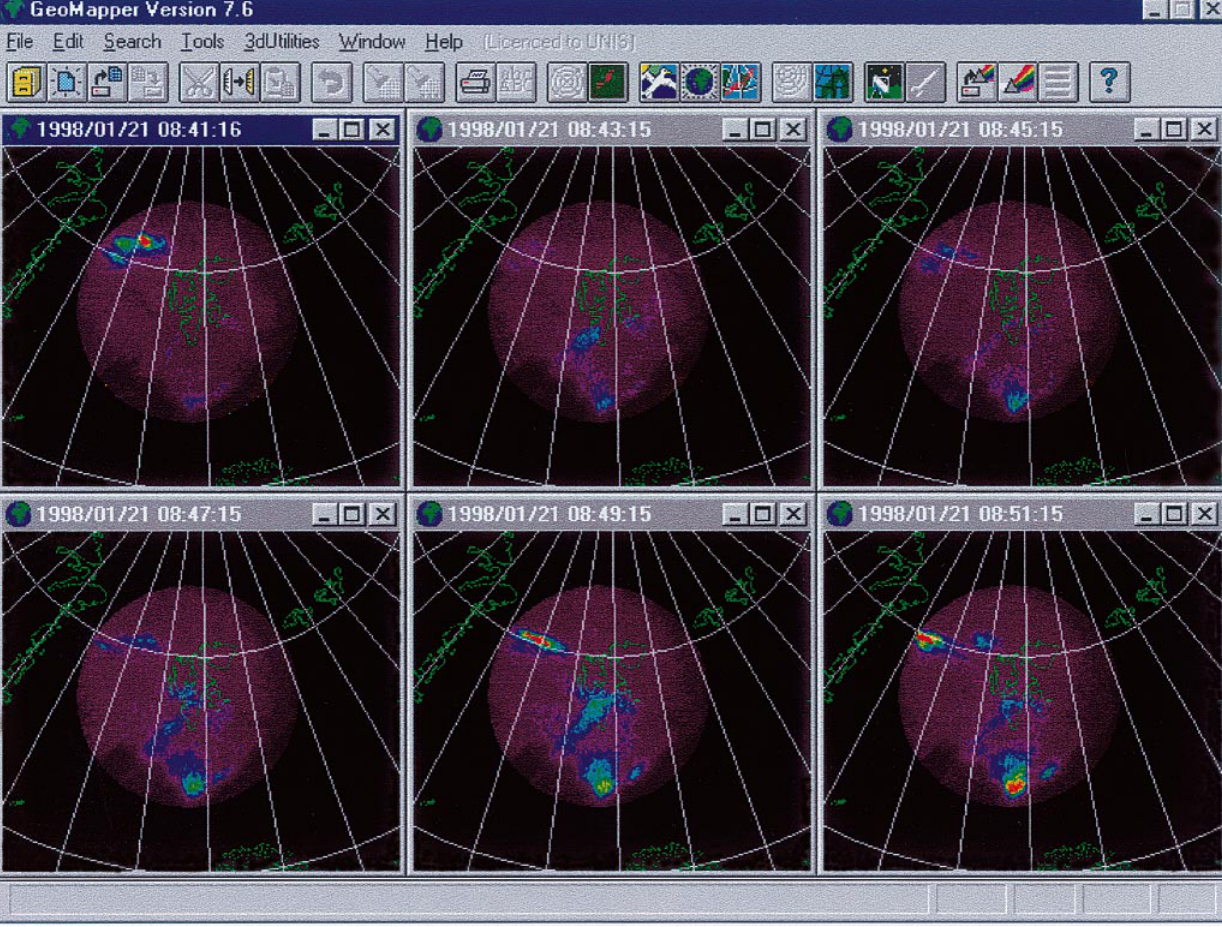
with the centre line , that passes through Svalbard, marking 20 (cid:176) E. The shaded circle shows the field-of-view of